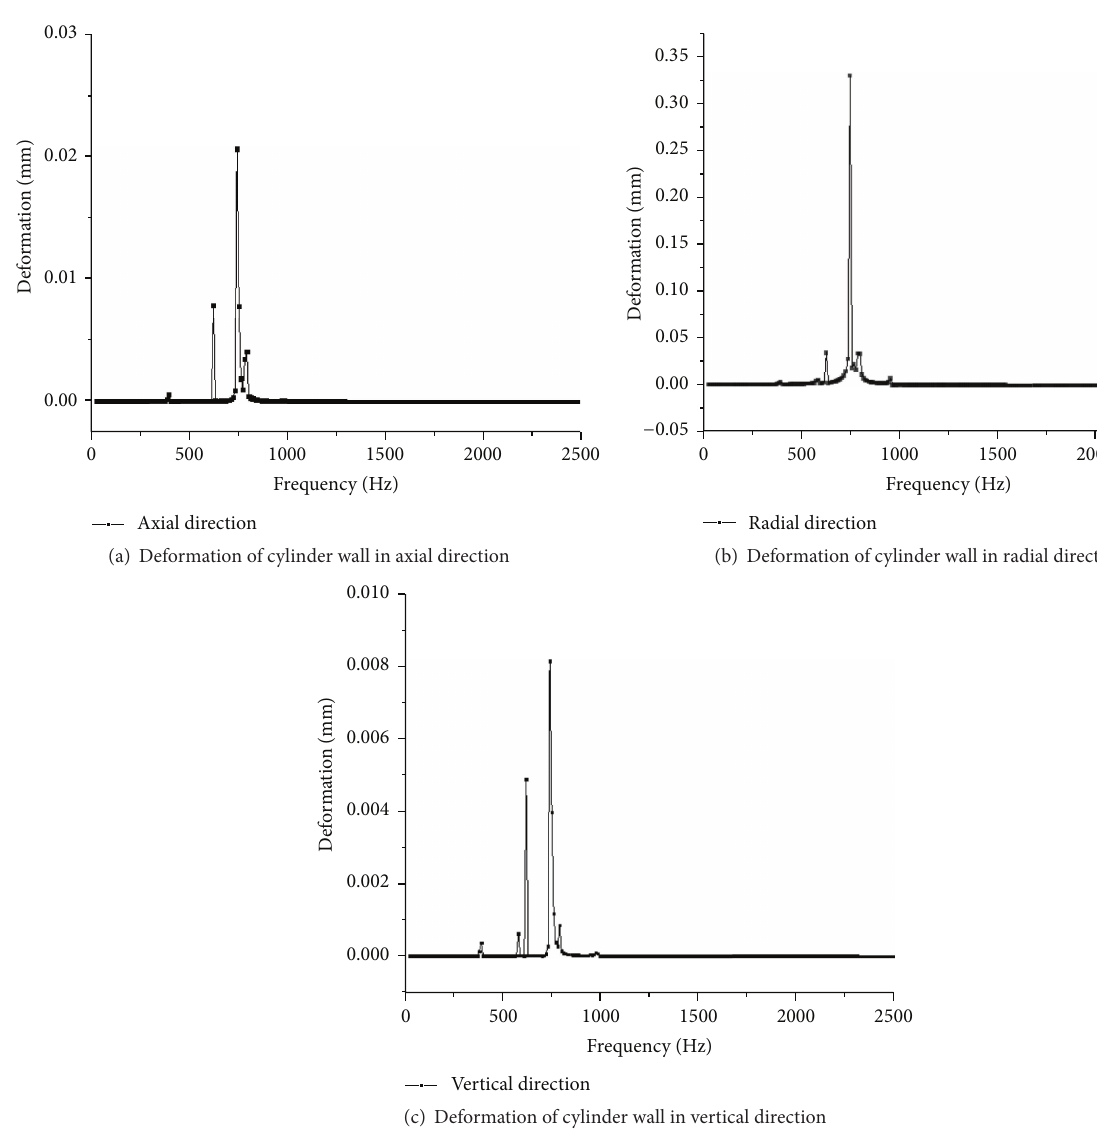
Figure 6: Deformation-frequency